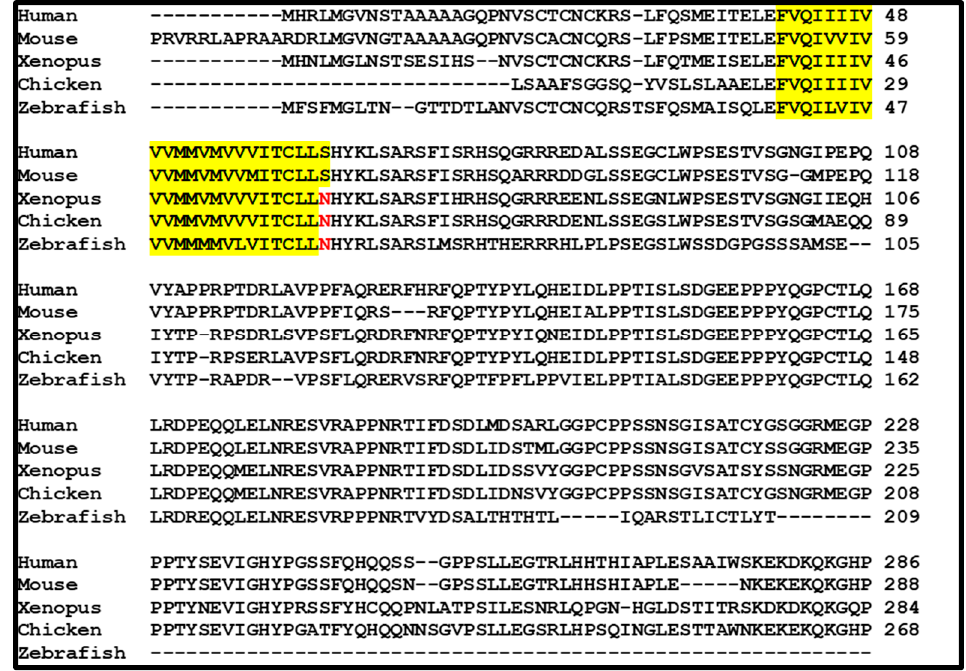
Figure 2. The alignment of the predicted amino acid sequence of PMEPA1 derived from di ff erent species. The sequences corresponding to the membrane spanning domain are indicated (yellow). Overall, the homology between di ff erent species is high in distinct regions of the protein. PMEPA1 from di ff erent species also show variation at the N-terminus like the pattern noted among the isoforms of human origin. Additionally, there are distinct di ff erences in the region close to the C-termini of the